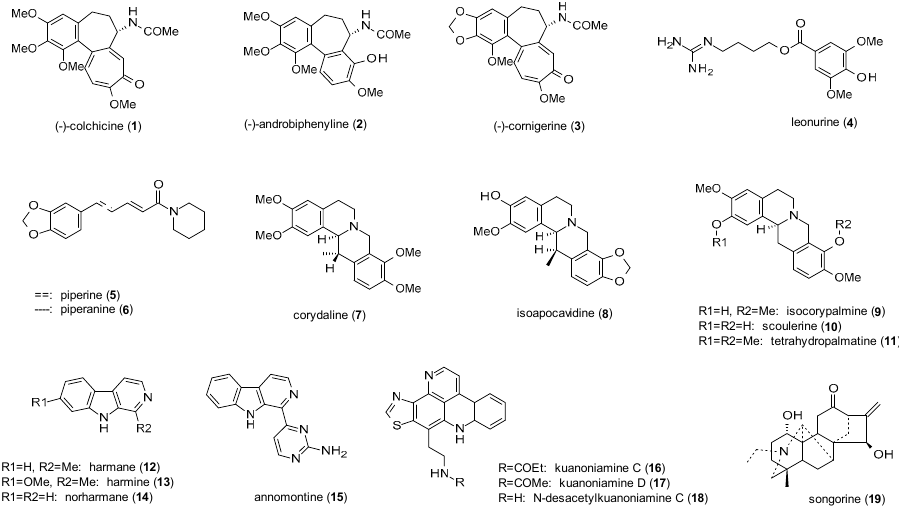
Figure 1. Chemical structures of alkaloids with reported GABA(A)-receptor modulating activity. Alali et